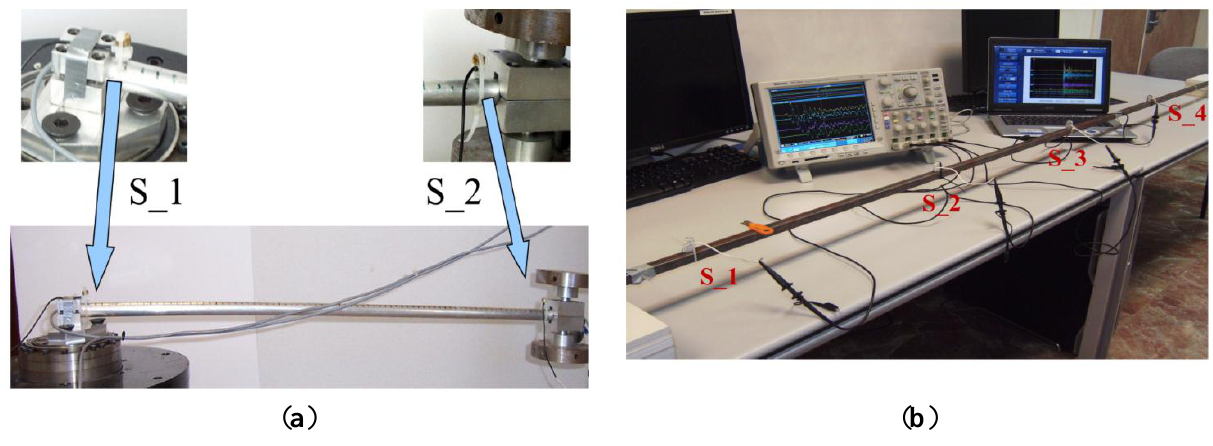
Figure 1. Experimental setup for an impact on a single bar with: ( a ) two piezoelectric sensors; ( b ) four piezoelectric